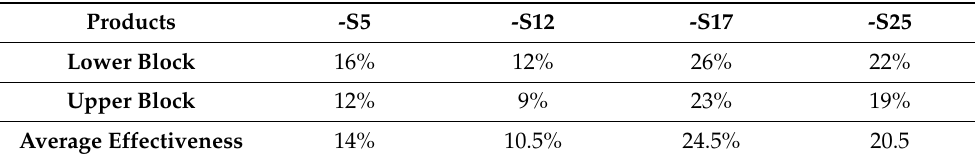
Table 1. Total temperature non-uniformity reduction of blocks with different spacer sizes in Config-1 compared to